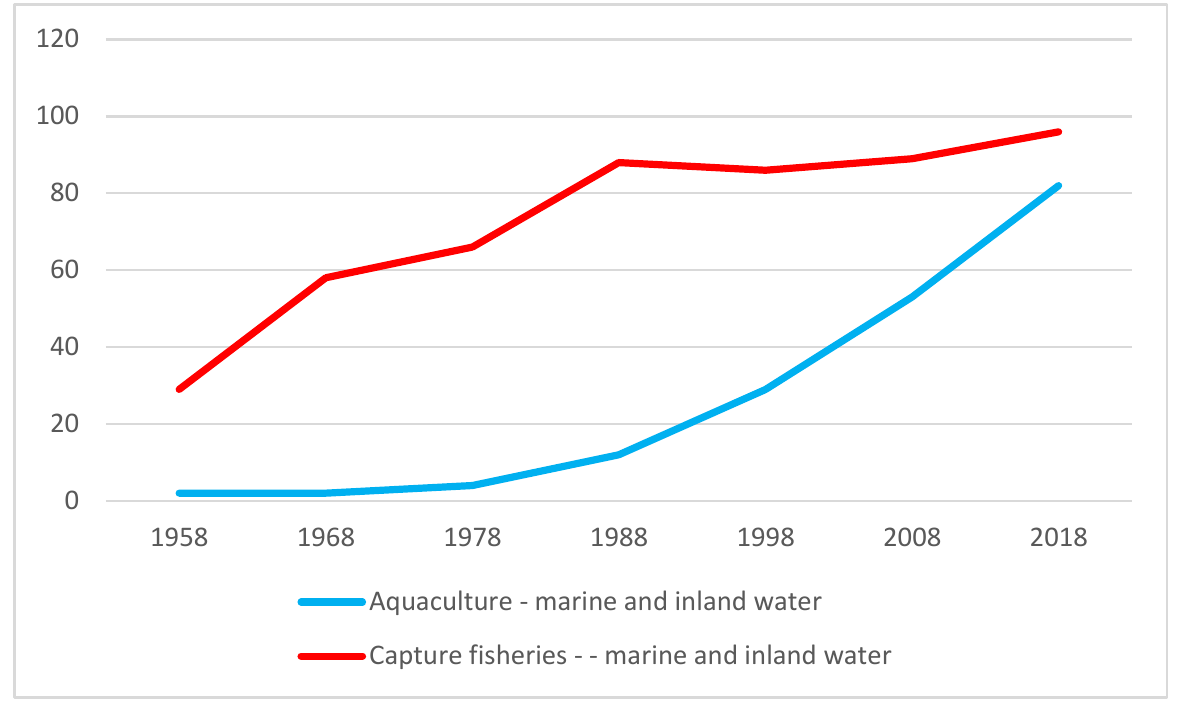
Figure 1. Capture fisheries and aquaculture production (in million tonnes). Source: own study based on [4] .